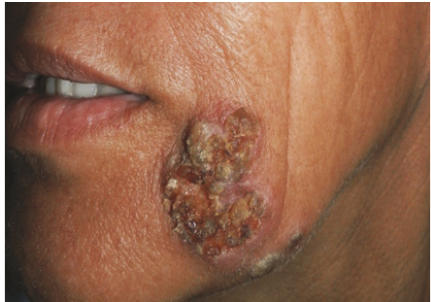
Figure 3: Plaque on chin after IVI Penicillin G treatment.